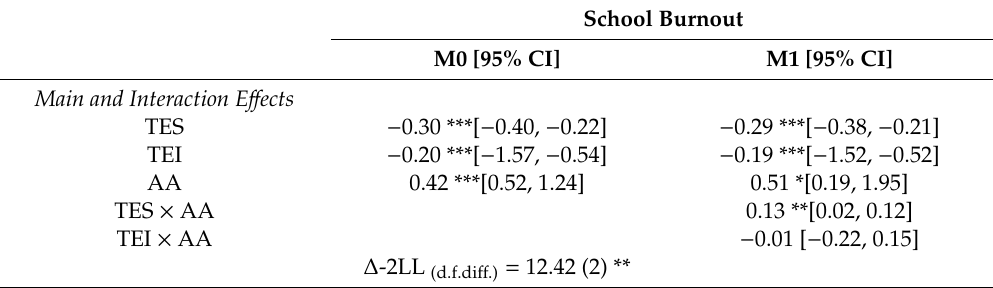
Table 2. Latent moderated structural equation modeling estimations of independent variables